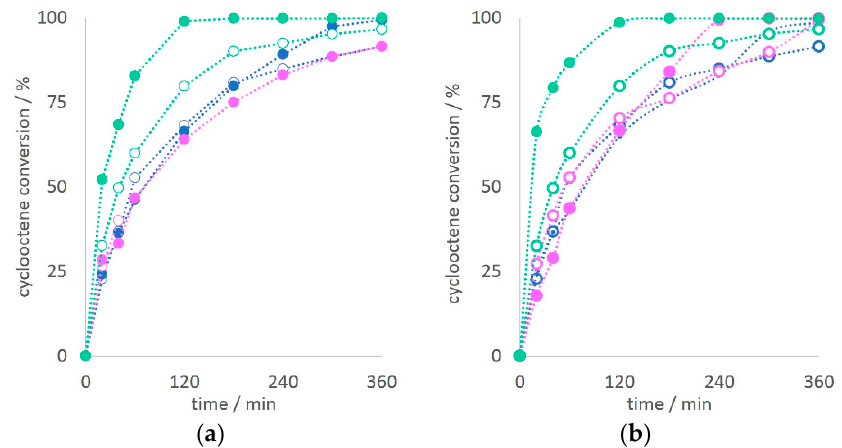
Figure 2. Kinetic profiles of cyclooctene conversion with ( a ) oligomeric catalysts and ( b ) monomeric catalysts. The colored sphere presents the reaction with TBHP in decane and the empty circle presents the reaction with THBP in water. Blue circles are complexes obtained from H 2 L H ligand, green complexes obtained from H 2 L 3OMe ligand, and pink complexes obtained from H 2 L 4OMe ligand. Table 2. Catalytic results of cis-cyclooctene epoxidation. Reaction conditions: time, 6 h; temperature, 80 °C, n (cata-